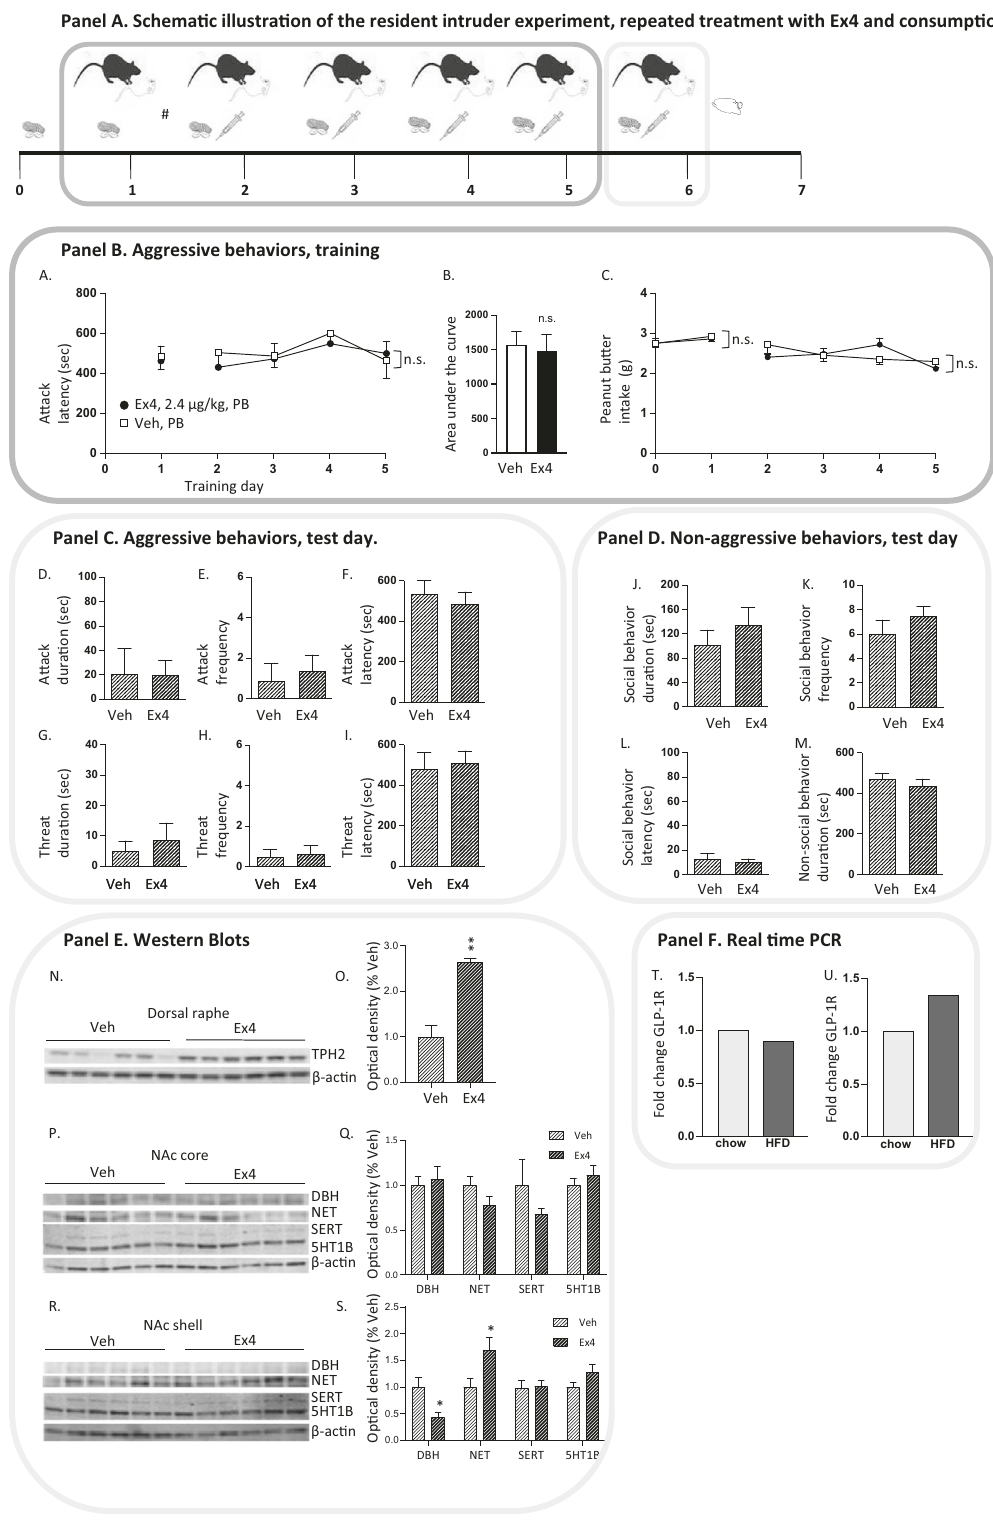
Panel A. Schema(cid:2)c illustra(cid:2)on of the resident intruder experiment, repeated treatment with Ex4 and consump(cid:2)on of HFD